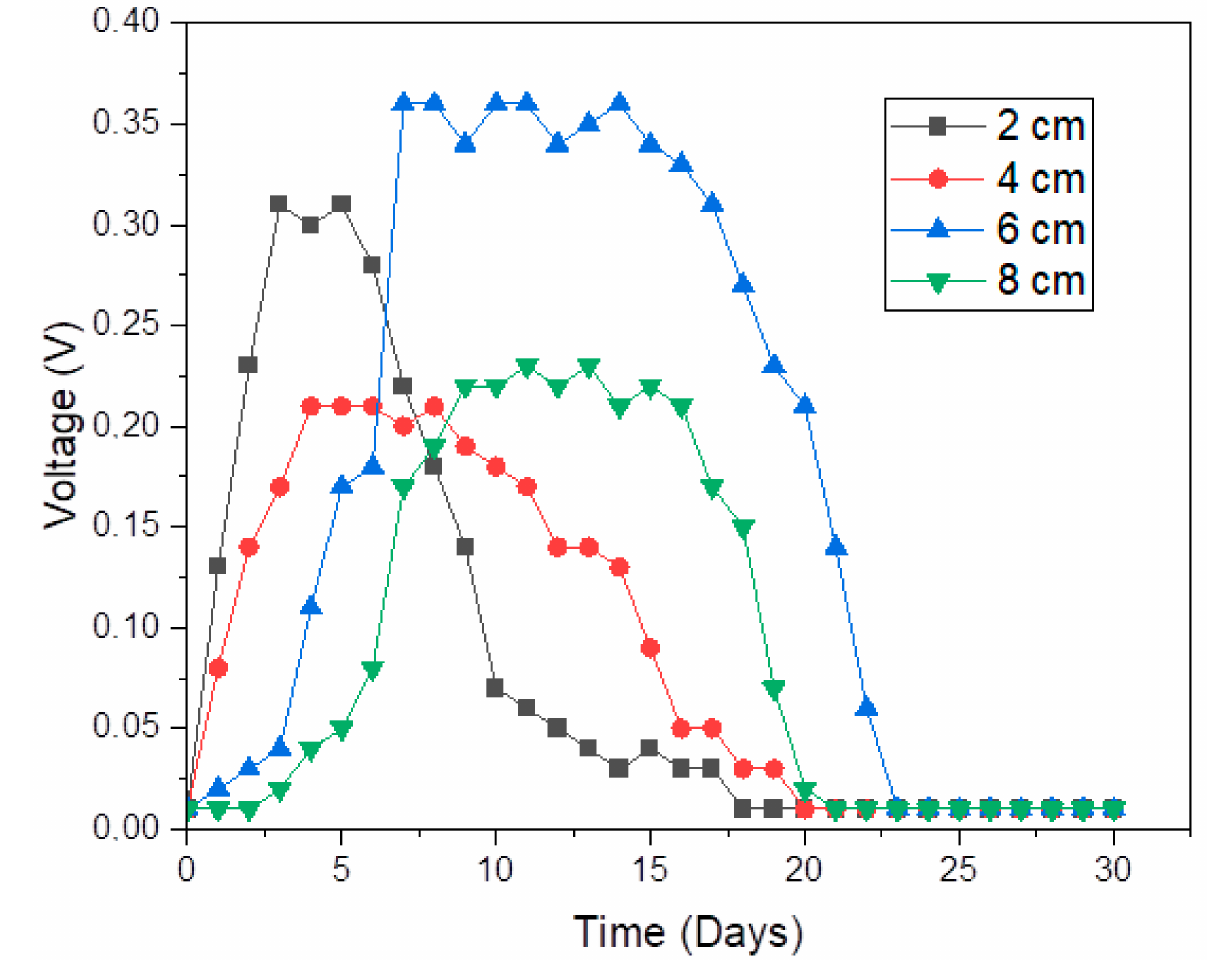
Figure 3. Voltage generation over